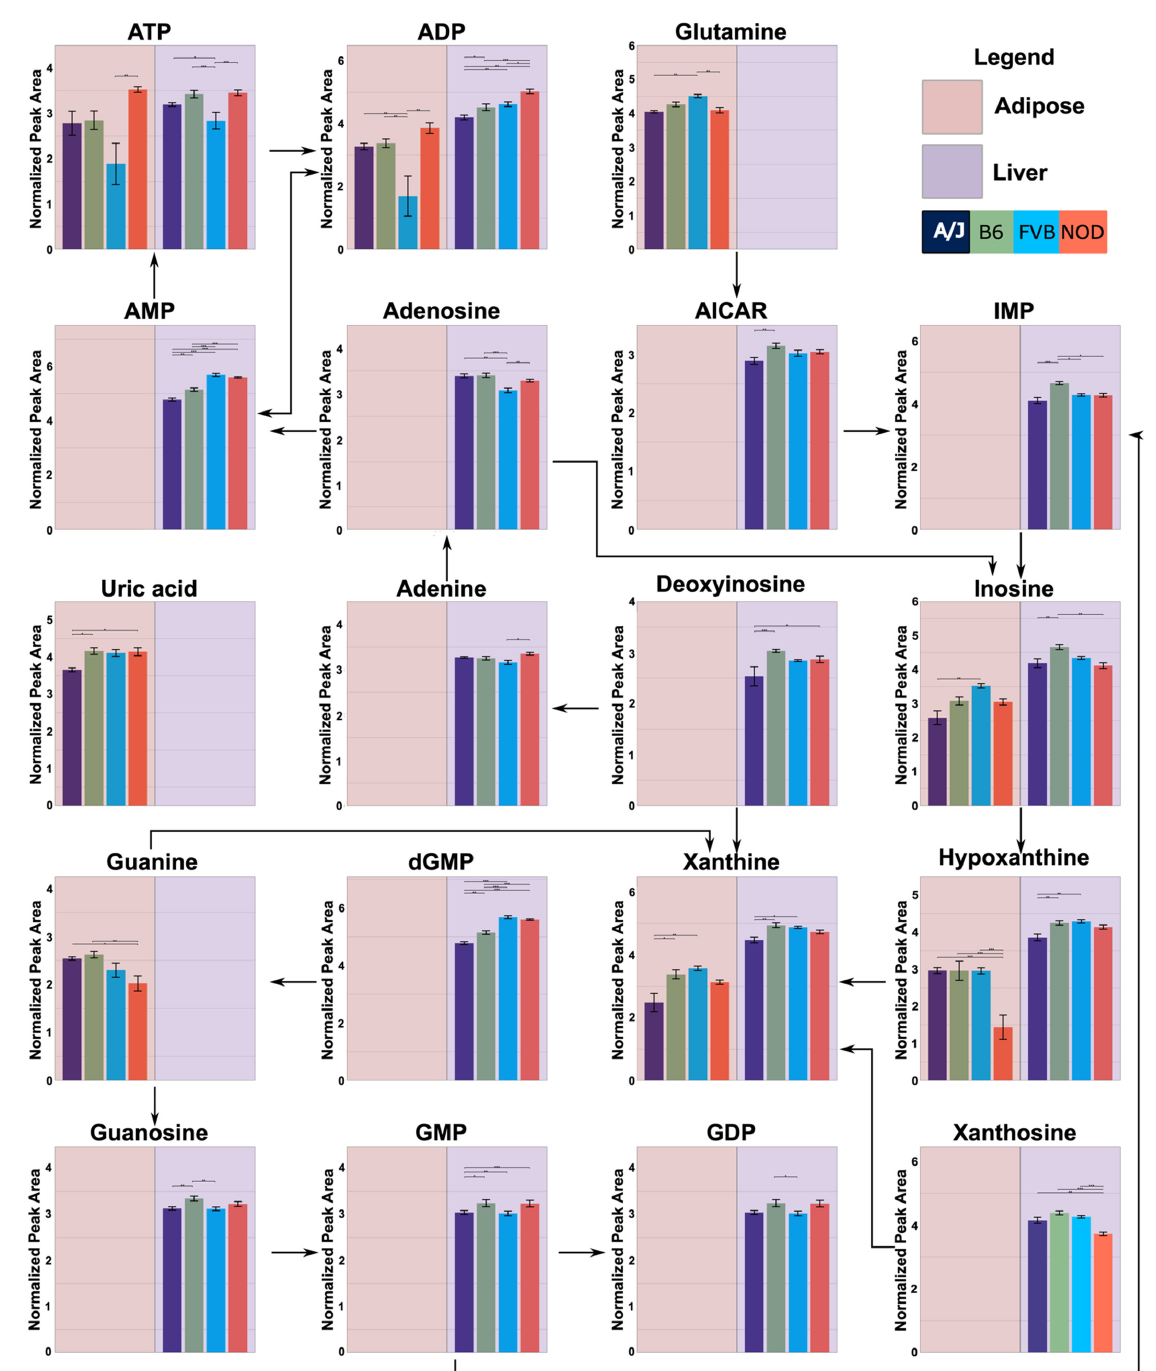
Figure 5. Strain-specific differences in purine metabolite levels in adipose and liver tissue. Metabolites that differed significantly between strains in adipose and/or liver were mapped onto the purine KEGG pathway. Significant differences between strains were determined using ANOVA and Tukey’s post hoc. Each bar plot was calculated by averaging the peak abundance of each mouse sample +/ − standard error. The y-axis represents the abundance of the metabolite in arbitrary units. The x-axis represents each strain, which is color-coded and listed in the legend. Connections between metabolites indicated by arrows are based on the purine KEGG pathway. Dashed lines represent missing metabolites in the pathway. Data for adipose or liver are only shown if strain significantly affected metabolite abundance. Horizontal bars represent pairwise comparisons performed using Tukey’s HSD post hoc analysis; * p < 0.05, ** p < 0.01, and *** p <